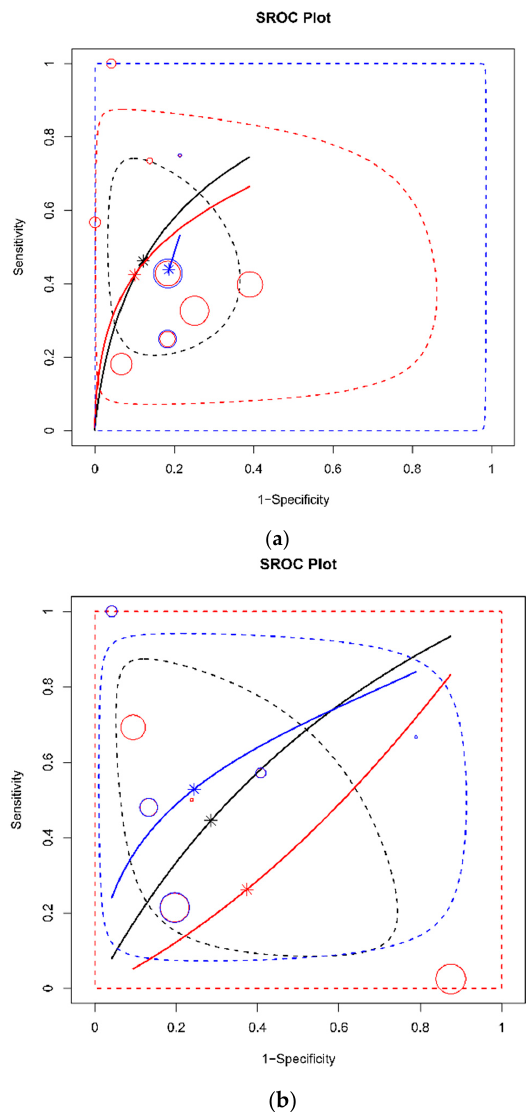
Figure 6. SROC plot to compare the result of each sub-analysis for shock development ( a ) and mortality ( b ). In the sub-analyses, for shock development ( a ), the black color represents the result of overall data, the red represents the result of data from the flat inferior vena cava (IVC) ratio ≥ 3, and the blue color represent the result of data from others (1.9 ≤ flat IVC ratio ≤ 2). In sub-analysis for mortality ( b ), the black color represents the result of overall data, the red represents the result of data from flat IVC ratio ≥ 3, and the blue color represent the result of data from others (1.9 ≤ flat IVC ratio ≤ 2 or not-reported). Each bubble represents one study and indicates its observed sensitivity and specificity. The size of the bubble is proportional to the number of individuals in the study. The solid line is the SROC line. The star point represents the summary estimate. The dashed line is the 95% credible region. 3.5. Publication Bias In terms of the DTA for development of shock, there was no asymmetry on visual inspection in Deek’s funnel plot, and there was no statistically significant asymmetry ( p = 0.20). However, in terms of the DTA for mortality, there was a significant asymmetry ( p = 0.03) (Figure 7).